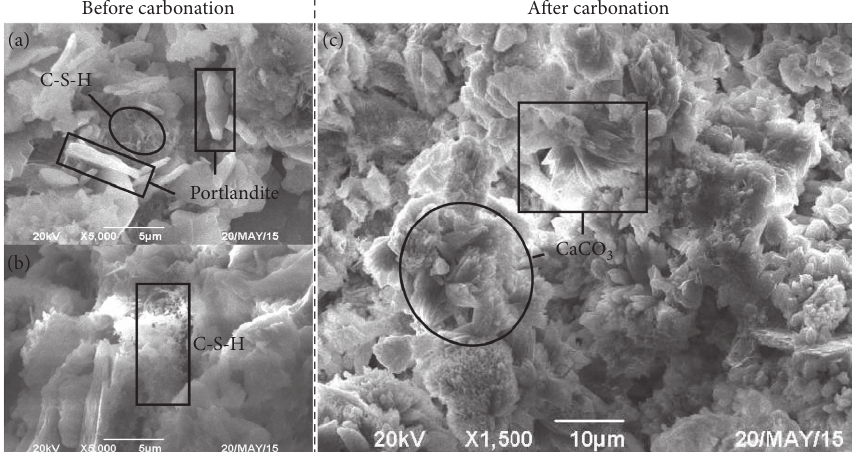
Figure 17: SEM results of different carbonated zones in the specimen. (a, b) Before carbonation. (c) After